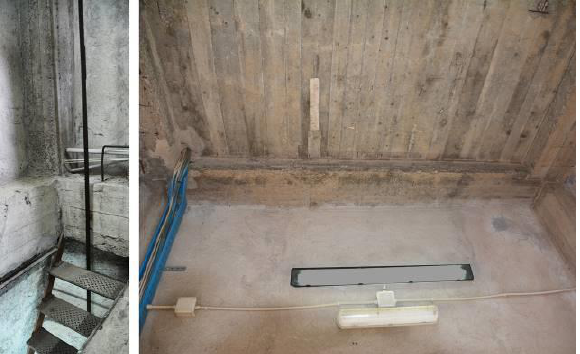
Figure 12. The new reinforced concrete structure in the bell tower of SS. Trinità in Bronte (Ct).